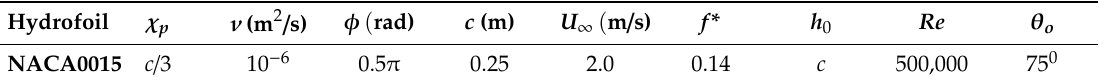
Table 2. Simulation parameter settings for validating the